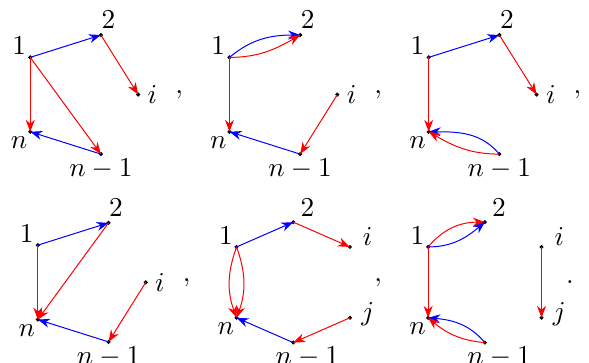
Figure 6 . Planar structures to eliminate corresponding to the factorised